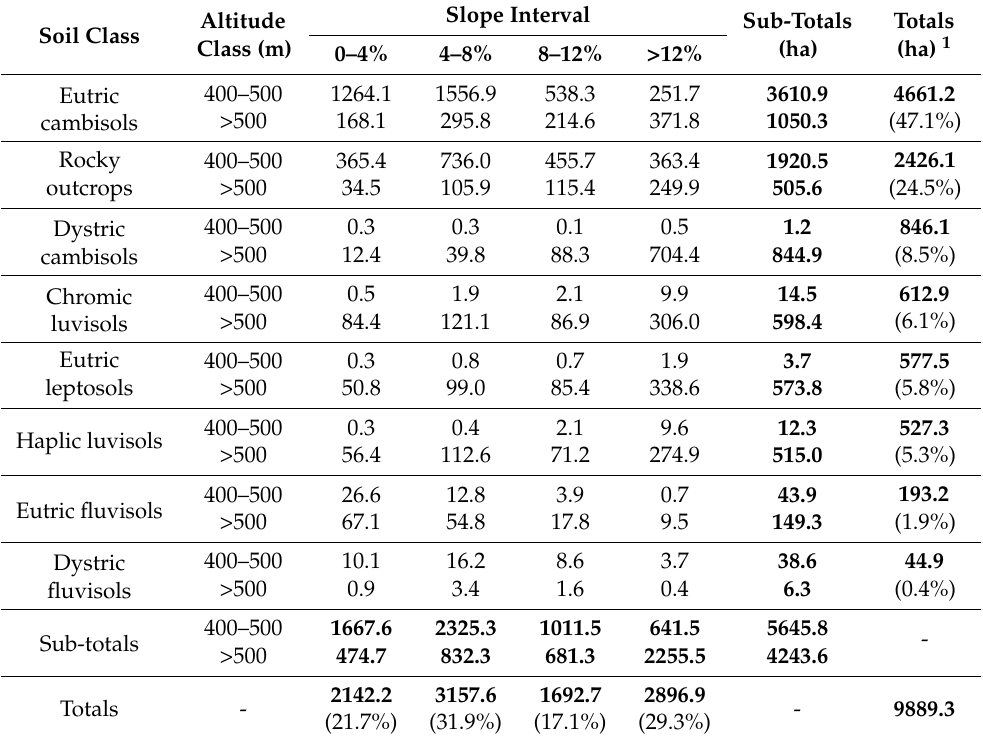
Table 5. Potential chestnut area (ha) by soil, slope, and